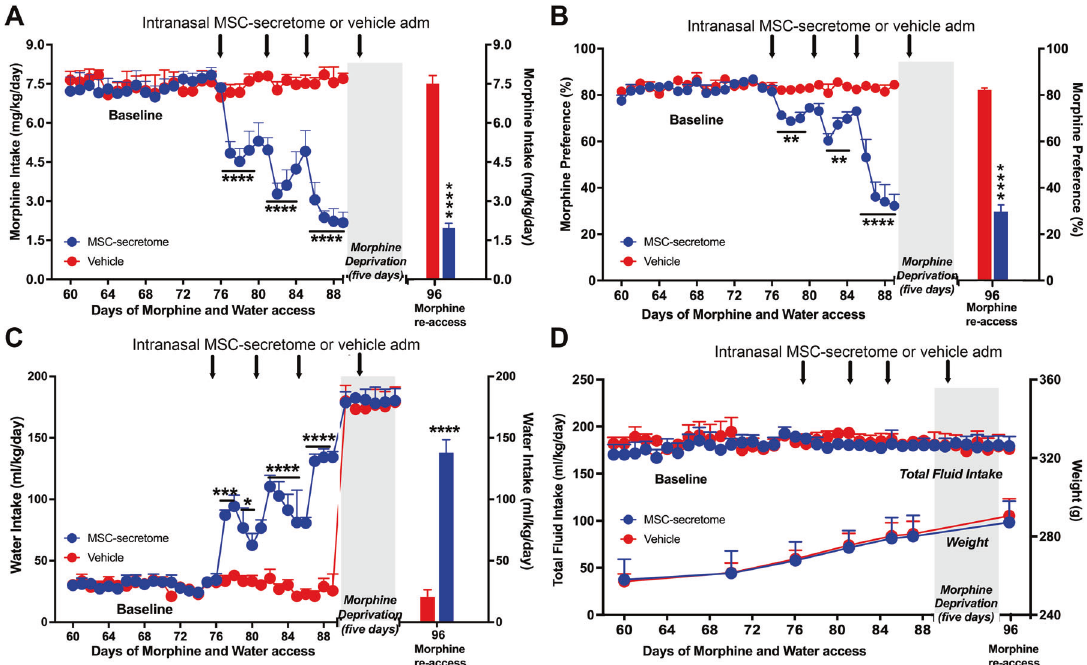
Fig. 4 Repeated intranasal administration of secretome derived from human preconditioned MSCs to UChB rats that had chronically consumed morphine inhibits its intake and reduces post-deprivation relapse. A -Left Daily morphine intake and ( B -Left) morphine preference over water. UChB rats that had consumed morphine for 76 days were intranasally treated with three doses of secretome derived from preconditioned MSCs or vehicle (indicated by arrows). Two-way ANOVA (treatment × day) of morphine intake following three intranasal doses of MSC secretome indicates signi fi cant effect of treatment [ F (1,180) = 195.4, p < 0.0001], day [ F (29,180) = 8.76, p < 0.0001], and signi fi cant interaction [ F (29,180) = 10.15, p < 0.001] compared with control rats receiving vehicle. Tukey´s post-hoc analysis revealed that secretome treatment (blue circles) inhibited morphine intake during the 14 days recorded period, versus vehicle-treated control (red circles) (*** p < 0.001). The inhibition of morphine intake induced by the third secretome dose (72%) was signi fi cantly higher (** p < 0.01) than the inhibition induced by the second dose (50%) and the inhibition induced by the latter was signi fi cantly higher (* p < 0.05) than the inhibition induced by the fi rst dose (34%) (two-tailed Student t test). ( A Right) Morphine intake and ( B Right) morphine preference over water of UChB rats after fi ve days of morphine deprivation followed by one day of free choice of 44 mg/l and 50 mg/l morphine re-access. Rats treated previously with four intranasal secretome doses (blue bar) ingested a 74% lower amount of morphine than vehicle treated animals (red bar) (**** p < 0.0001; Two-tailed Student t test). ( C Left) Daily water intake showing that intranasal administration of three secretome doses (blue circles) signi fi cantly increased water intake compared with vehicle treated rats (red circles). Two-way ANOVA (treatment × day) indicates signi fi cant effect of treatment [ F (1,216) = 213.9, p < 0.0001], day [ F (35,216) = 104.7, p < 0.0001], and signi fi cant interaction [ F (35, 216) =